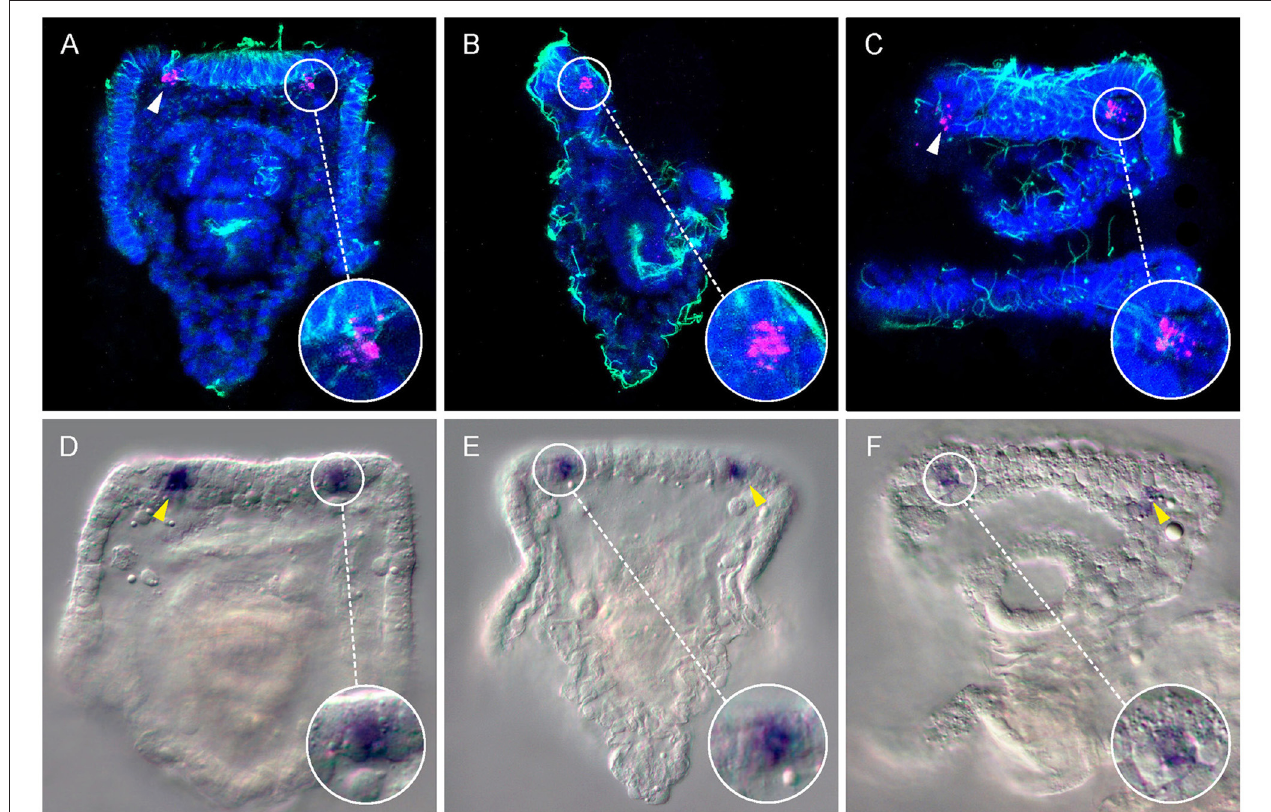
FIGURE 1 | Expression of the Go-opsin Sp-opsin 3.2 in early plutei. A couple of Sp-opsin 3.2 bilateral symmetrical cells were detected at cellular resolution between the base of the anterolateral arms and the apical organ of echinopluteus by means of fluorescent ( A–C , 3dpf) and chromogenic ( D–F , 4dpf) in situ hybridizations. (A–C) Confocal-micrographs; Sp-opsin3.2 in situ hybridization (magenta) was coupled with acetylated α -tubulin immunohistochemistry (green); nuclei were counterstained with DAPI (blue). (A) Abanal view; (B) right-lateral view; (C) mouth view. (D–F) Light-micrographs. (D,E) abanal view; (F) mouth view. Arrow heads indicate Sp-opsin3.2 positive